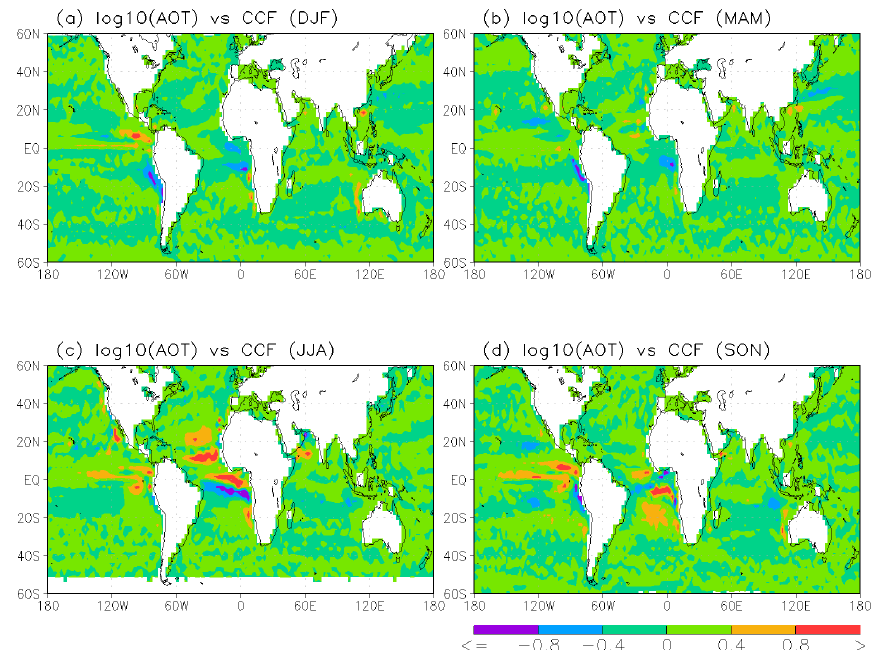
Figure 11. Similar to Figure 8 but shows the global maps of the linear correlation slope for log 10 ( AOT ) vs. CCF in four seasons: ( a ) DJF; ( b ) MAM; ( c ) JJA; and ( d ) SON.